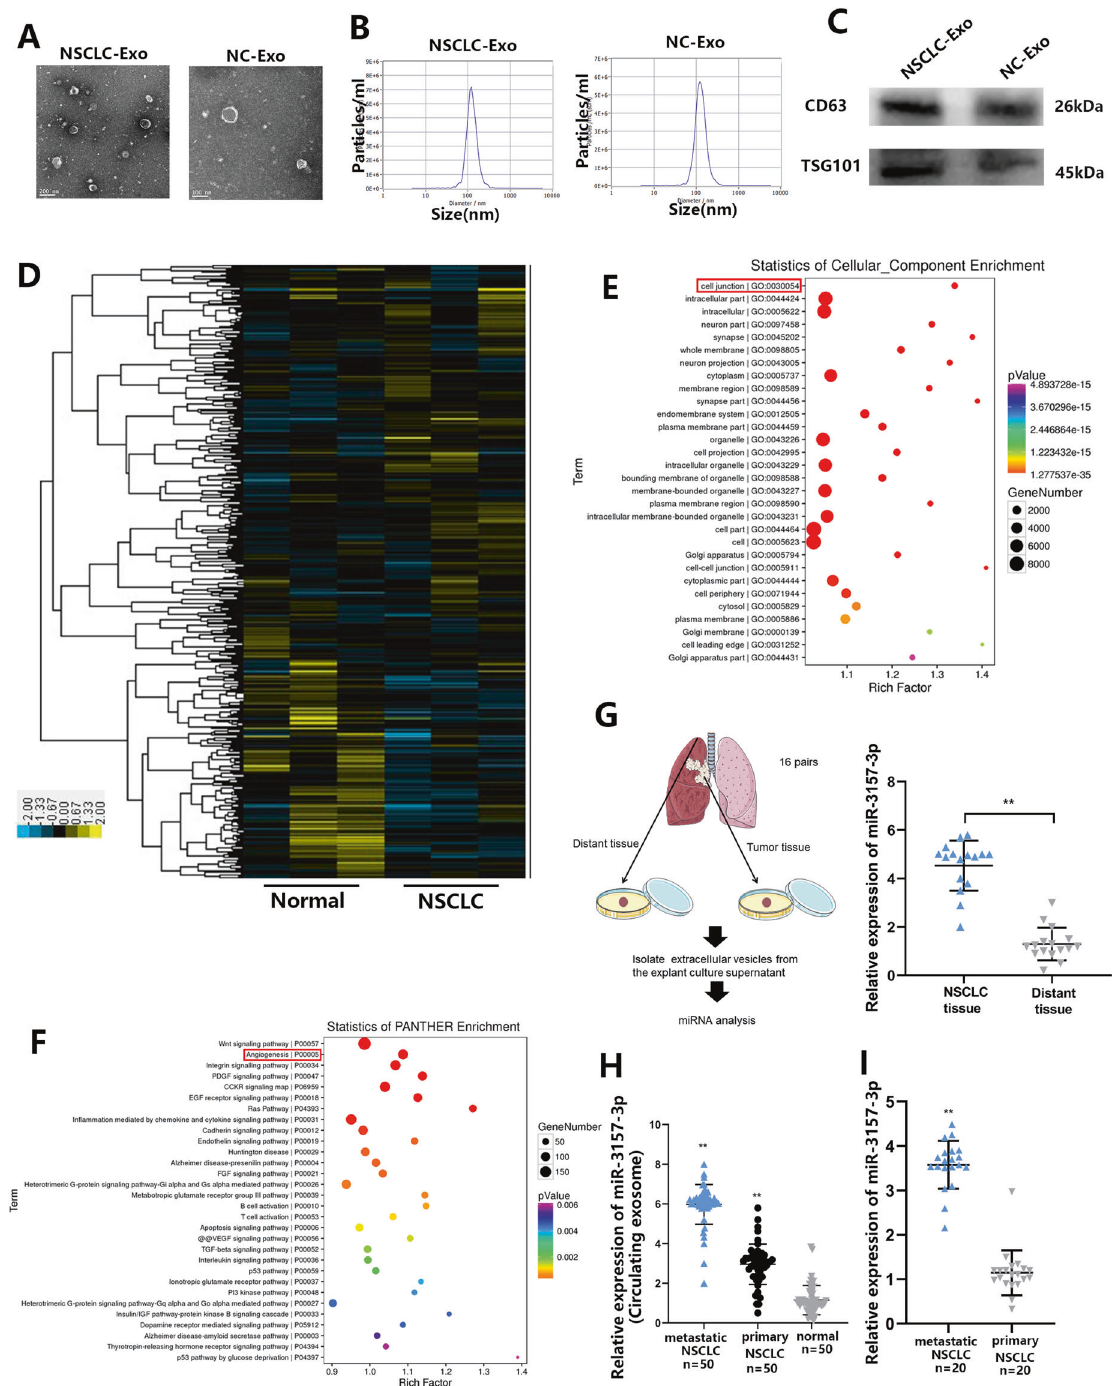
Fig. 1 Exosomal miR-3157-3p is abundant in NSCLC patients. A The morphology of exosomes was examined by TEM. B The exosomes were quanti fi ed by nanoparticle tracking analysis. C CD63 and TSG101 were determined by western blot. D A heatmap representing microarray data for the indicated NSCLC patient plamsa exosomes with metastasis and corresponding normal plasma exosomes. Three clinical samples were pooled in each group. E , F GO enrichment analysis of DEGs: Two histograms refer to the cellular component (CC) and panther enrichment. G 16 pairs of explants of NSCLC tumors and distant healthy lung tissues were cultured in vitro, and the expression of miR-3157-3p of EVs isolated from the culture supernatant of explants was measured. H The expression levels of miR-3157-3p in plasma exosomes from NSCLC patients (50 with metastasis, 50 without metastasis and 50 noramls). I qRT-PCR analysis of miR-3157-3p expression in NSCLC tissues with or without metastasis (20 with metastasis and 20 without metastasis). The data are shown as the mean ± SD ( ** P <